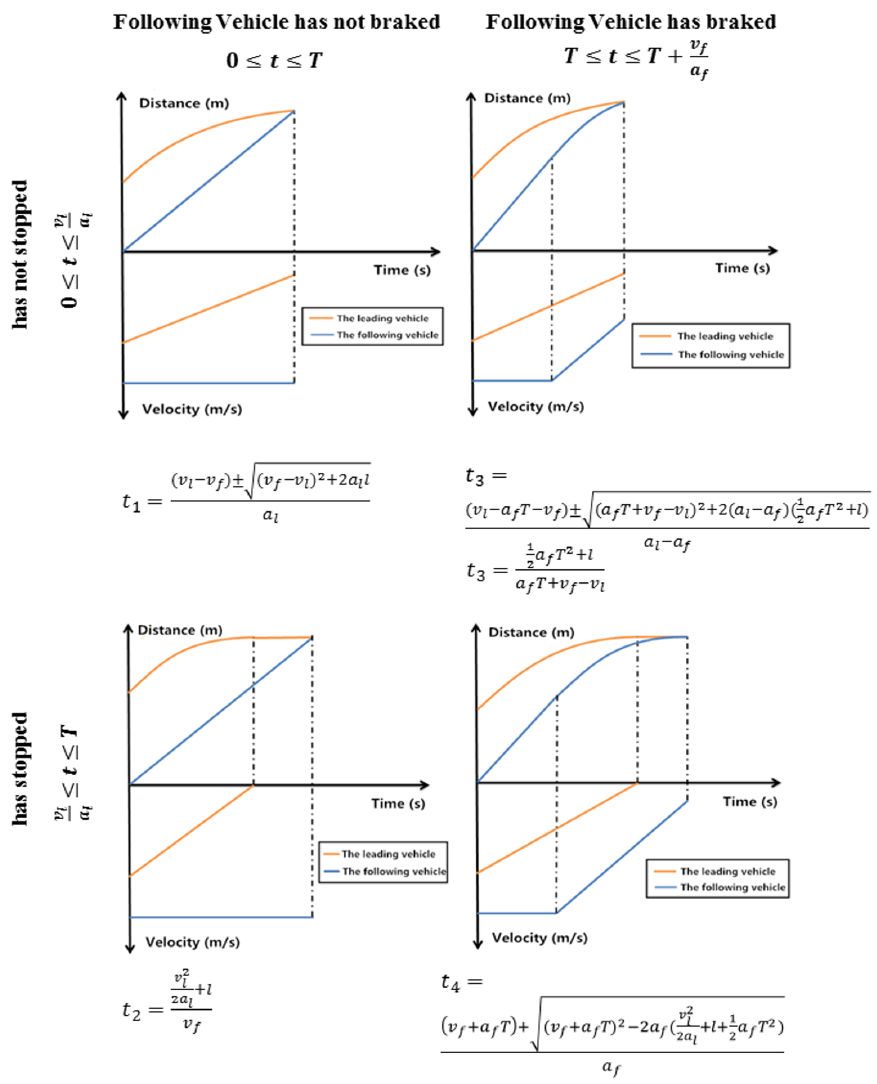
Fig 5. Descriptions of distance-time-velocity relationship in the four situations in the rear-end collision